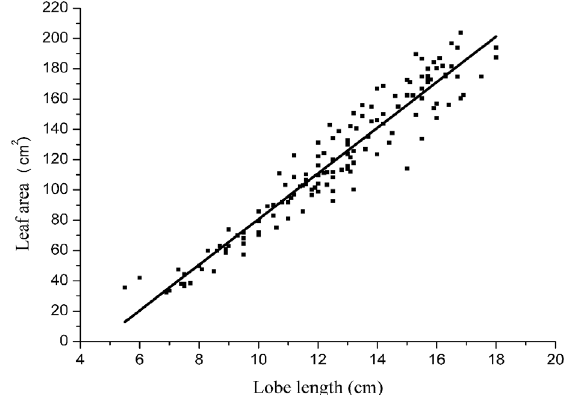
Figure 2 - Estimate of the leaf area (LA) in function of length (L) of the central lobe using the fit linear LA = -69.91114 + 15.06462L in cassava leaves, cultivar IAC 576-70, at 80 days after planting in the region of Botucatu, SP,